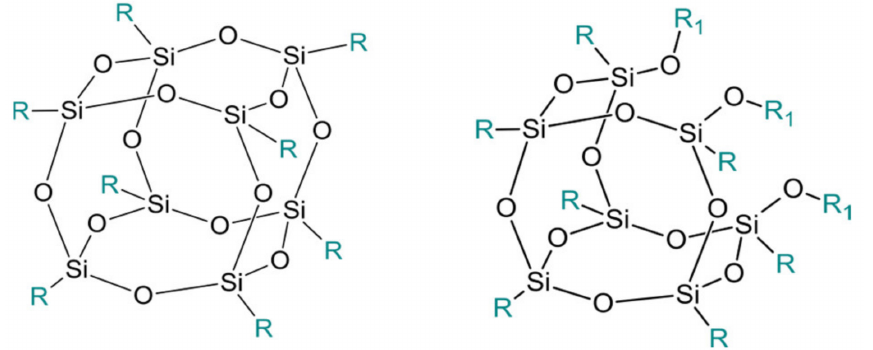
Figure 1. The general structure of closed-cage POSS ( left ) and partially opened-cage POSS ( right ). R represents organic substituents functionalizing the POSS cage, while R 1 represents organic or silica-organic